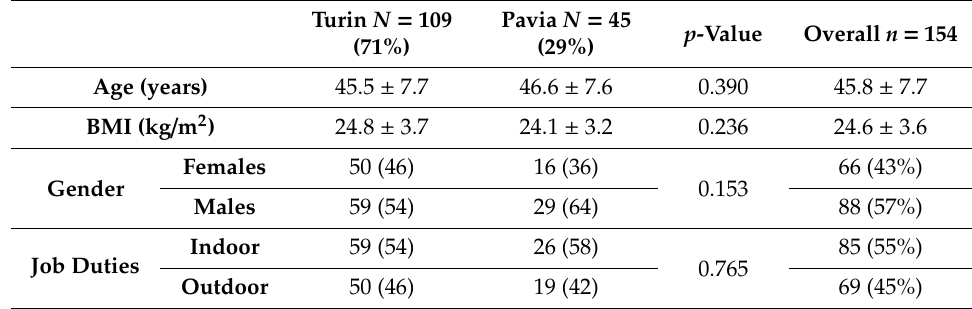
Table 1. Numerical and percentage characteristics of subjects. The statistical di ff erences between the two cities are reported. Age: Mann–Whitney (M–W) U-test, BMI t-test; gender and job duties: X-square test.